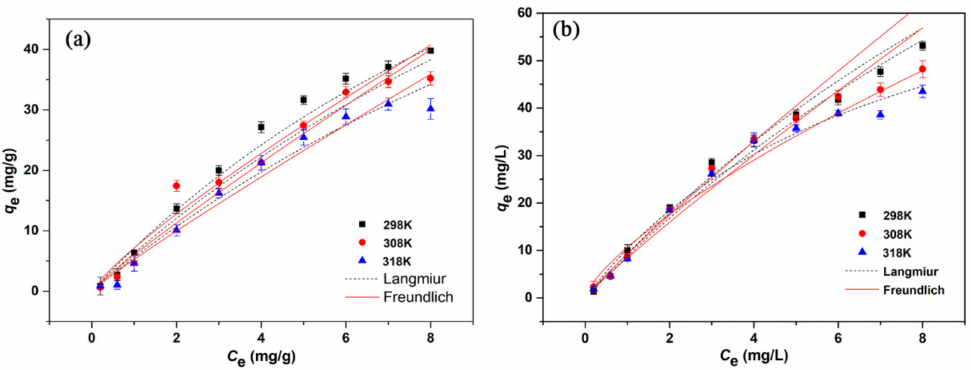
Figure 5. Isotherms of E2 adsorption by ( a ) BC and ( b ) 1:1 / 900 ◦